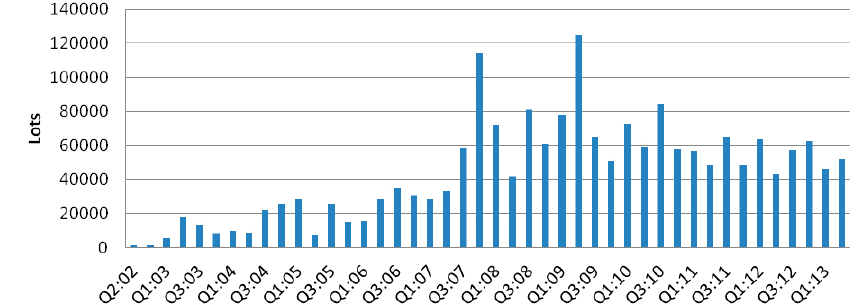
fig. 2. a-reIt futures quarterly transaction volume: